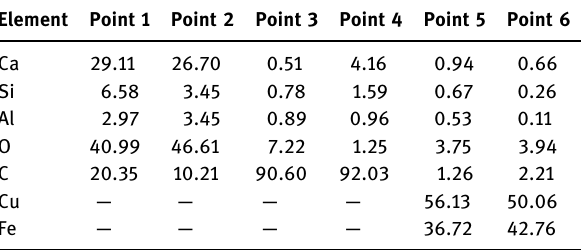
Table 5: Element mass percentage of fi ber surface